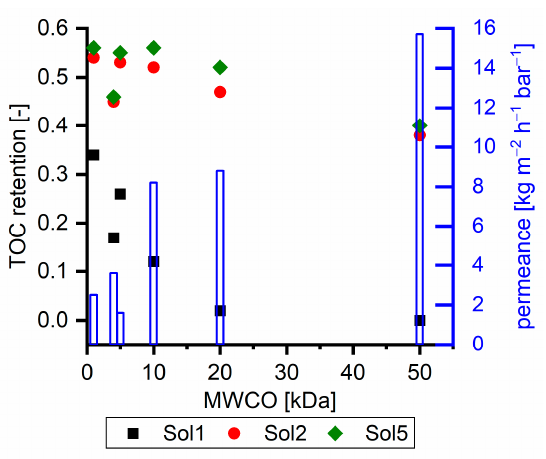
Figure 6. TOC retention of different ultrafiltration membranes with dependency on their MWCO examined with different solutions. The blue bars show the corresponding permeance examined with Sol1. NP010, UH004, and UP005 at a pressure of 15 bar; UP010 and UP020 at a pressure of 5 bar; and UH005 at a pressure of 3 bar.